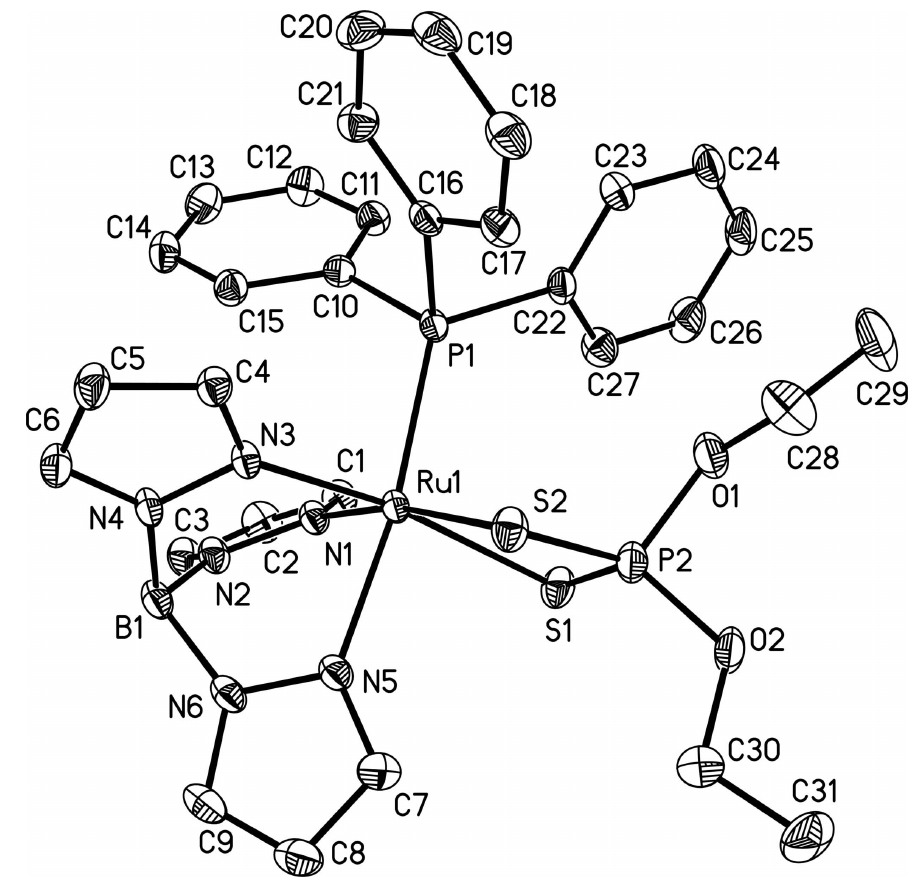
Figure 1 Molecular structure of (I) showing displacement ellipsoids at the 35% level and H atoms having arbitrary radius. The disorder is not